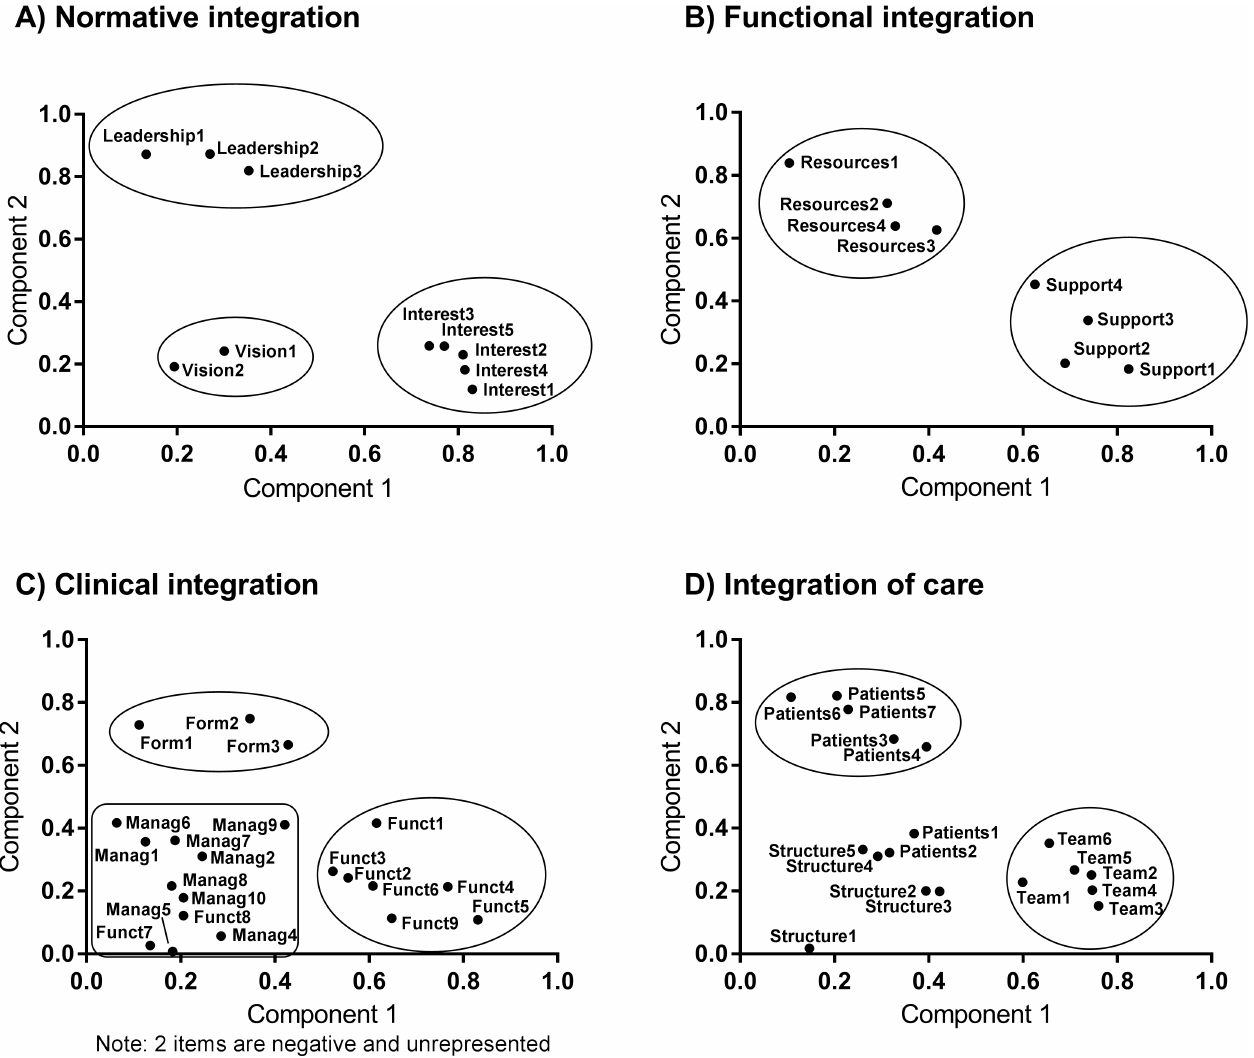
Fig 2. Graphical representation of principal component analysis for each dimension of integration.